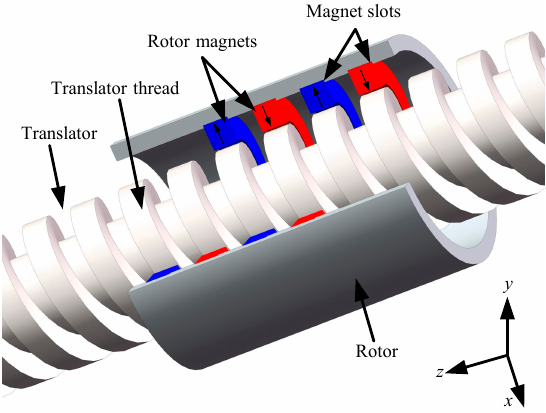
Figure 2. The proposed reluctance lead screw (RLS).